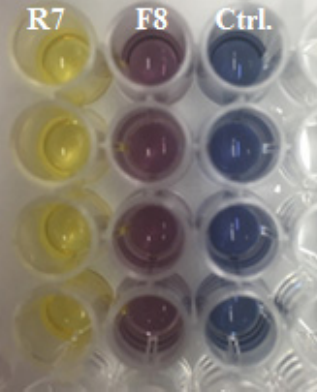
Figure 2. Estimation of siderophore production by two actinomycetes isolates in liquid CAS medium. Siderophore production is positive in both isolates R7 (color changed from blue to yellow) and F8 (color changed from blue to pink) compared to the control (blue, no color change).